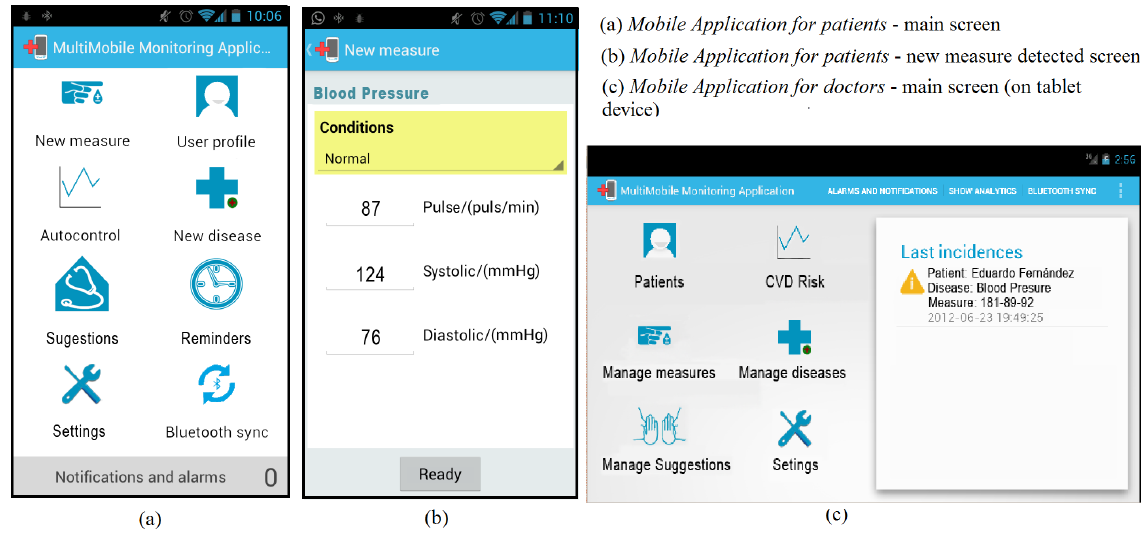
Figure 6. Mobile application graphical user